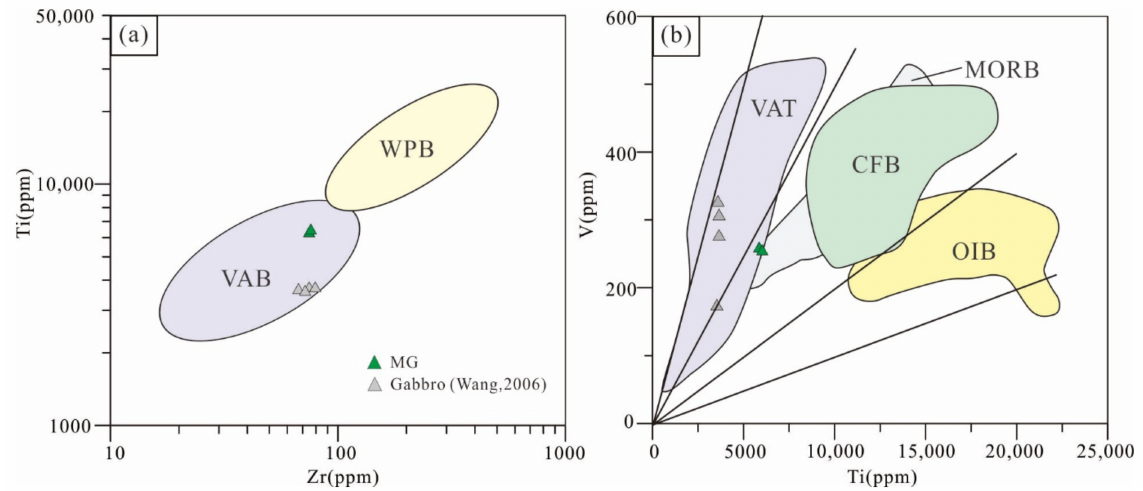
Figure 13. ( a ) The Zr versus Ti diagrams [73]; ( b ) The Ti versus V diagrams [74]. VAB: Volcanic Arc Basalt; WPB: Intra Plate Basalt; VAT: Volcanic Arc Tholeiite; CFB: Continental overflow Basalt; MORB: Mid Ocean Ridge Basalt; OIB: Ocean Island